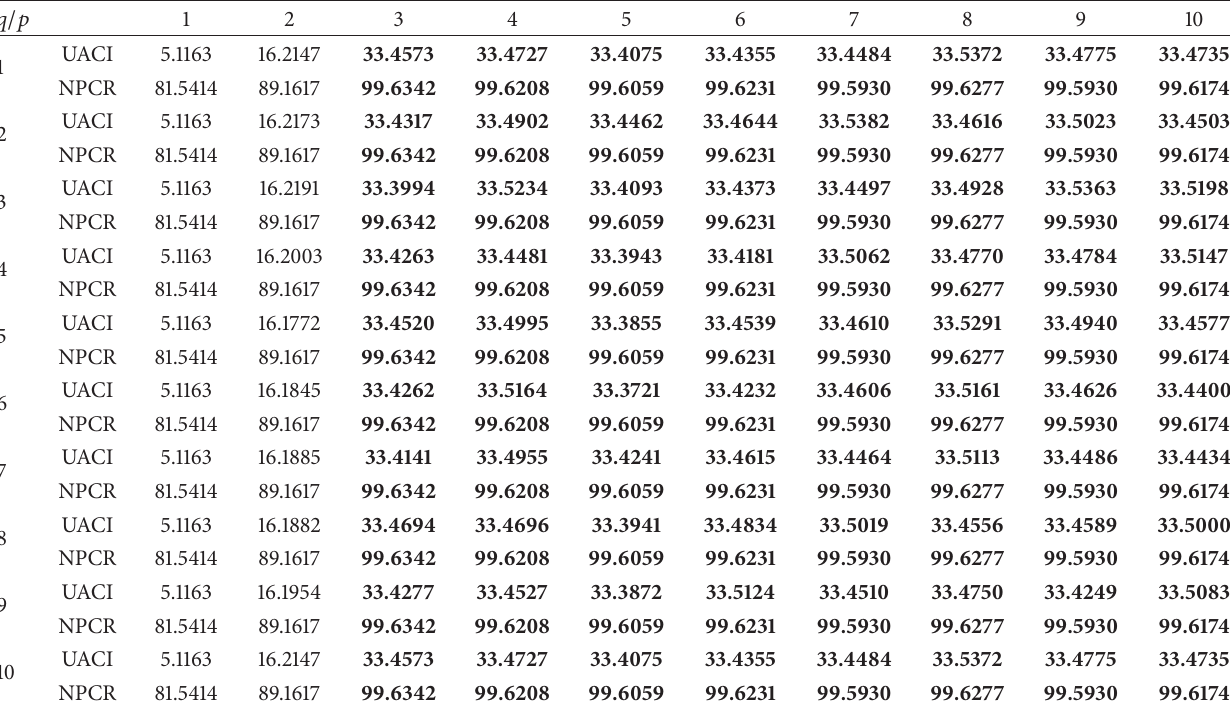
Table 9: Calculated UACI and NPCR for different combinations of 𝑞 and 𝑝 while 𝑟 = 1 in